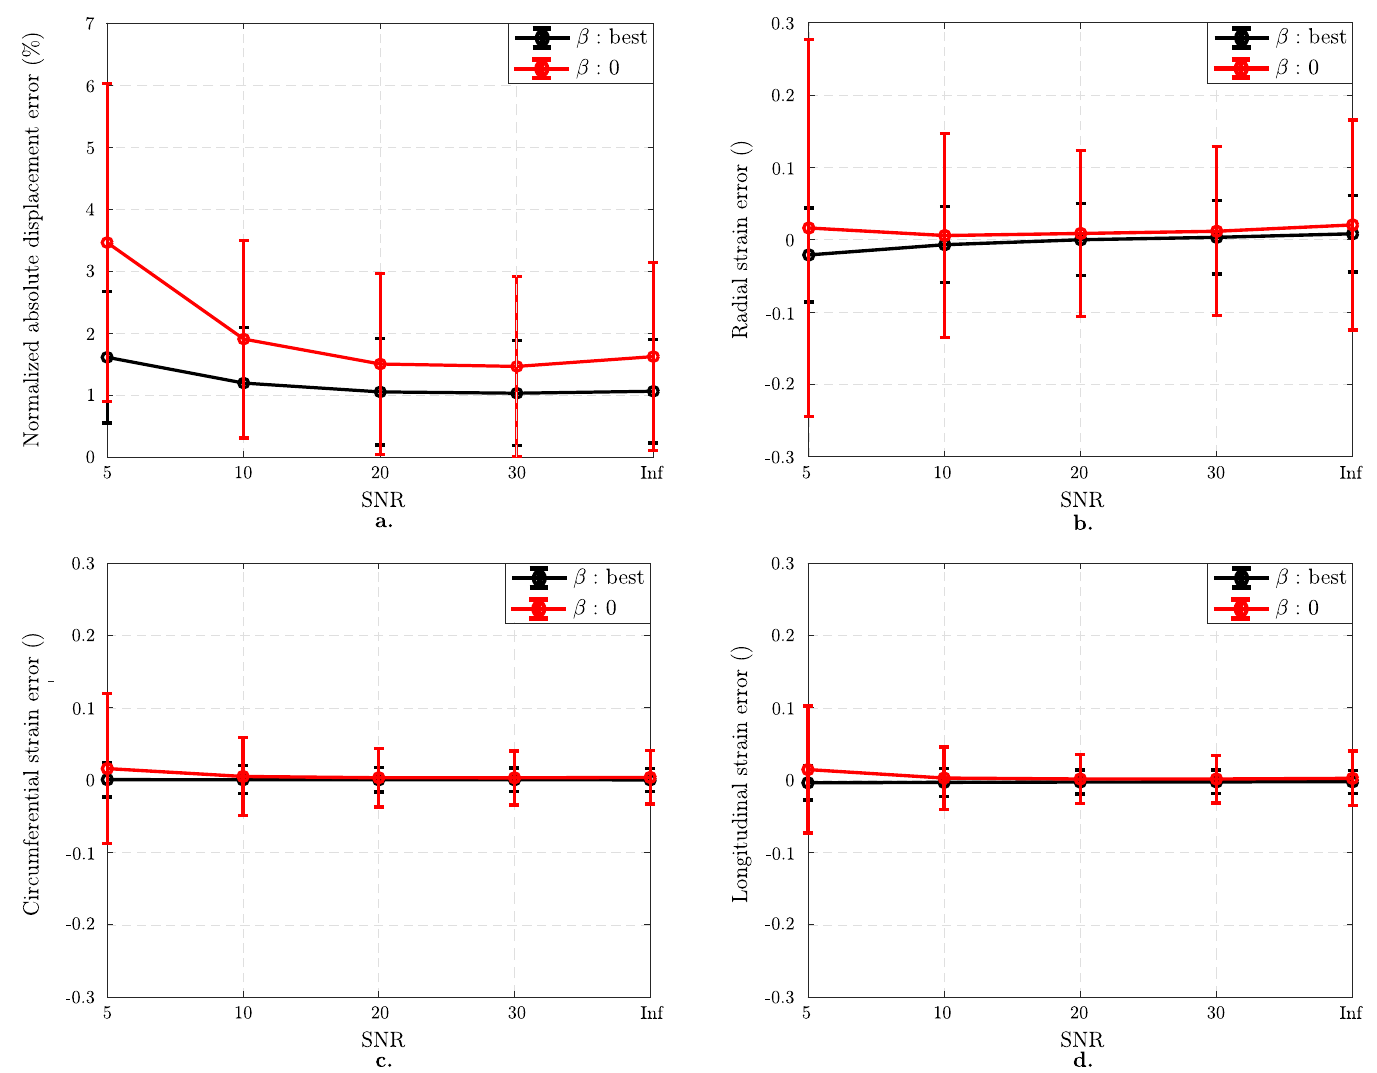
Fig 5. Effect of SNR on isotropic image analysis. Results on images with 1 mm pixel size and 7 mm tag distance. Normalized mean ± standard deviations in displacement error norm (%) without regularization (red curve) and with optimal regularization (black curve) (a). Regularization helps decreasing the registration error significantly. Mean ± standard deviations in component-wise Green-Lagrange strain error as a function of SNR which is independent of regularization strength for SNR � 20 (b-d).